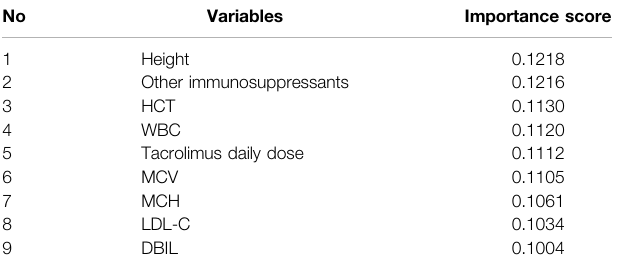
TABLE 3 | Variable importance scores